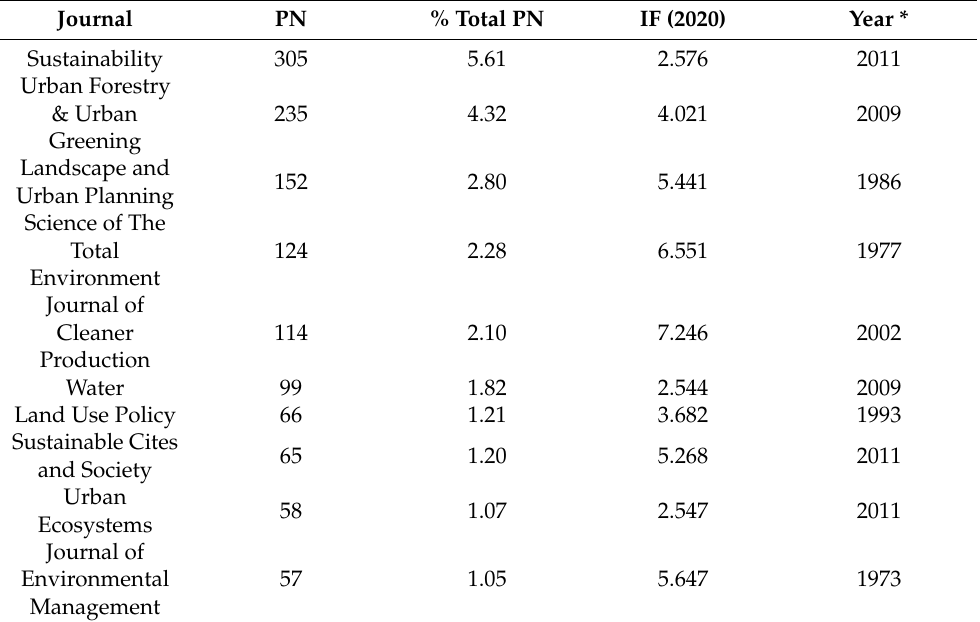
Table 2. Top 10 journals by number of